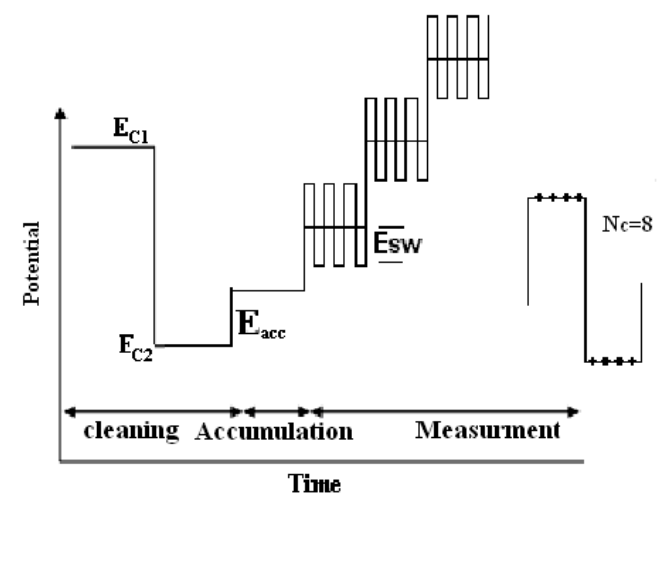
Figure 3. Diagram of the potential waveform used in